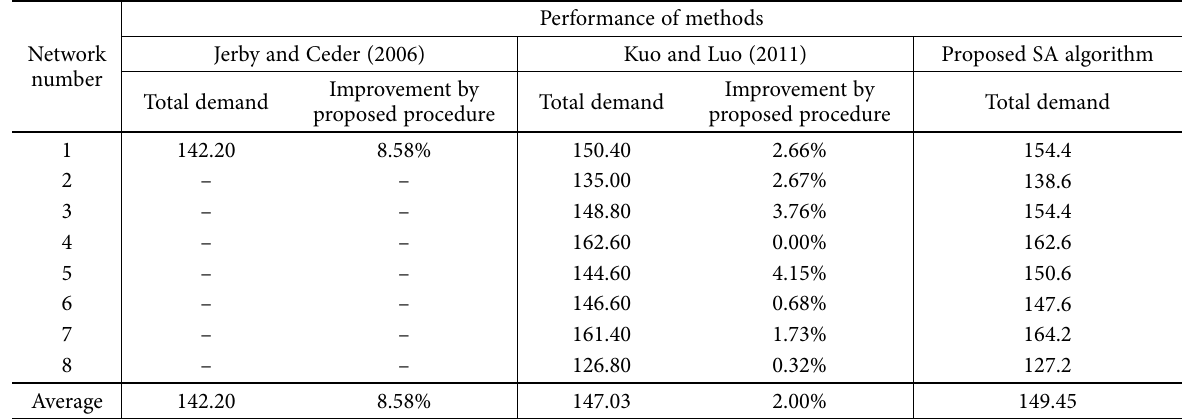
Table 3. The experimental